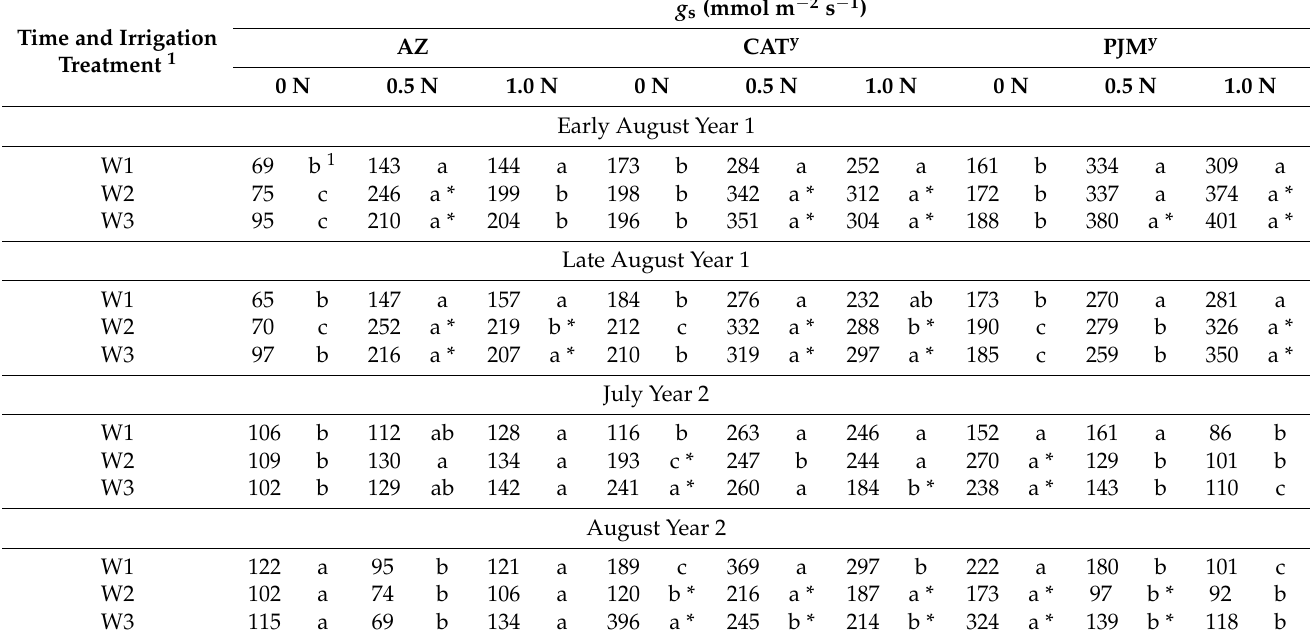
Table 4. Stomatal conductance ( g s ) in ‘Gibraltar’ (AZ), ‘Catawbiense Album’ (CAT), and ‘P.J.M.’ (PJM) Rhododendron . In Year 1, plants from each cultivar were grown in soilless media with N-free fertilizer (0 N) or N-free fertilizer plus 7 (0.5 N) or 14 (1.0 N) mg N per day from NH 4 NO 3 and irrigated once daily to 100% (W1) or 50% (W2) container capacity or twice daily to 100% container capacity (W3). In year 2, the plants were transplanted into